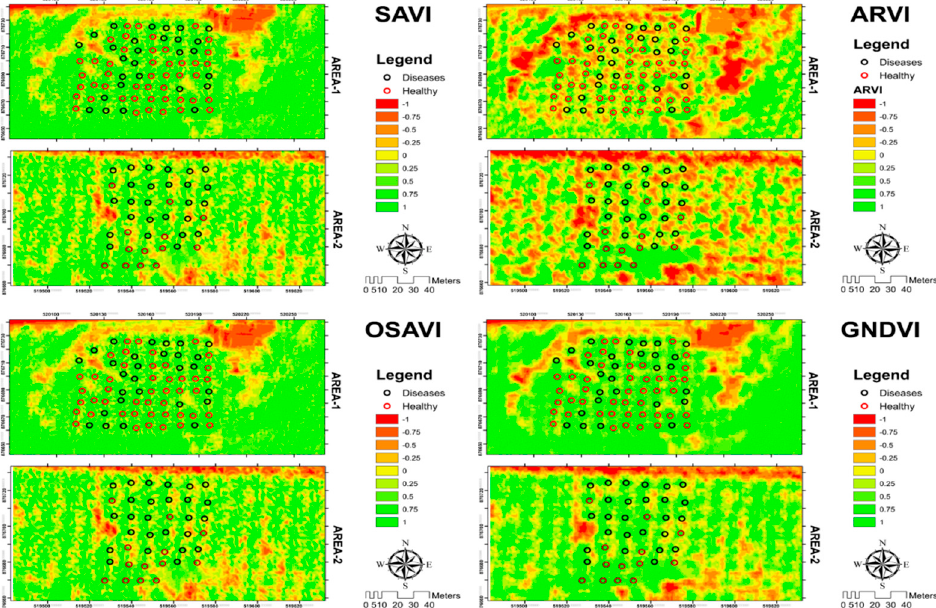
Figure 8. Visualization of the spectral vegetation indices (SAVI, ARVI, OSAVI and GNDVI).